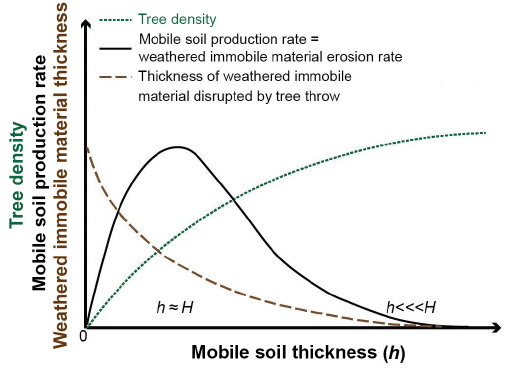
Figure 3. Conceptual relationship proposed by Gabet and Mudd (2010) showing (i) tree density (green dotted line), (ii) production rate of mobile soil (black line), and (iii) thickness of weathered im- mobile material that is disrupted by tree throw (brown dashed line), all plotted as a function of the mobile soil thickness. As shown, the tree density and the thickness of weathered immobile material dis- rupted by tree throw events are thought to vary with thickness of the mobile soil ( h ). With increasing soil thickness, the tree density in- creases, while the thickness of immobile material disturbed during tree turnover decreases. Over geomorphic timescales, the mobile soil production rate is inferred here to equal the product of tree den- sity times thickness of bedrock disrupted by each tree throw times tree throw frequency (not shown). In a steady-state landscape, this mobile soil production rate is equivalent to the weathered immobile material erosion rate. The rate first increases and then decreases be- cause thin soils support too few trees to create mobile soil from im- mobile material at a significant rate, but thick soils insulate under- lying immobile material from significant root disturbance. We hy- pothesize that maximum soil production by tree throw occurs when the thickness of mobile soil ( h ) ≈ thickness of all weathered mate- rial ( H